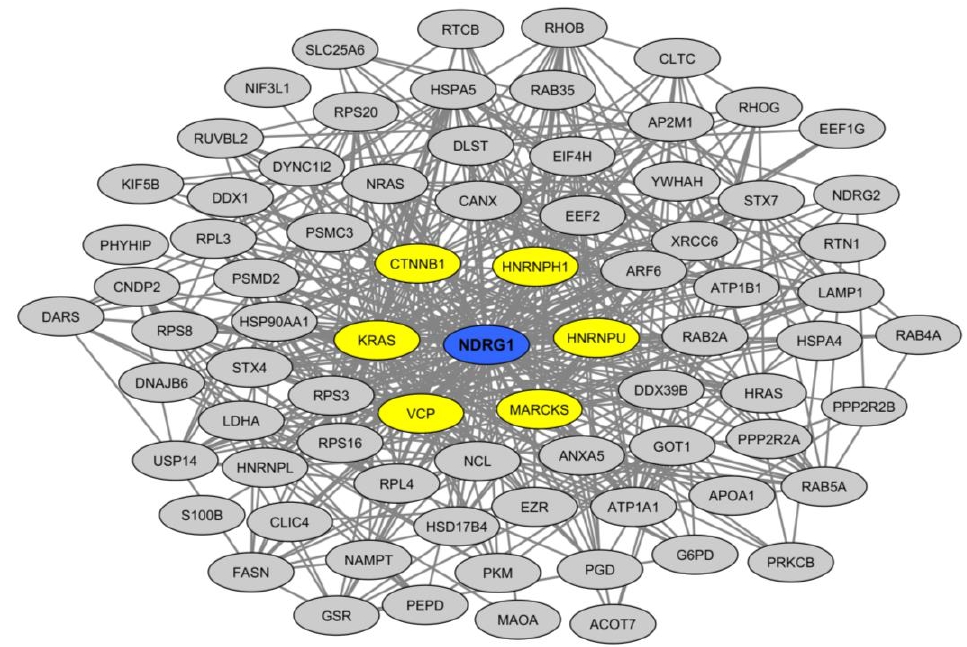
Figure 3. Protein–protein interaction network linking NDRG1 with myelinic protein partners. Hubs Figure 3. Protein – protein interaction network linking NDRG1 with myelinic protein partners. Hubs are shown in are shown in yellow.